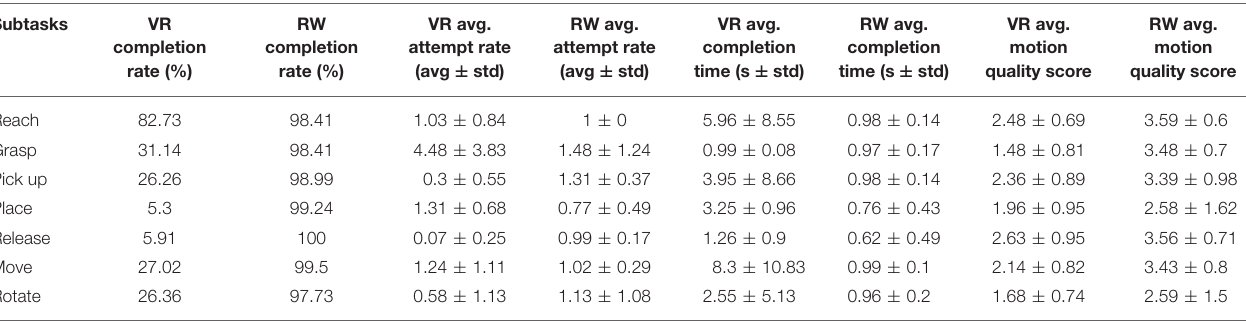
TABLE 4 | Summary of analyzed subtask characteristics for VR and